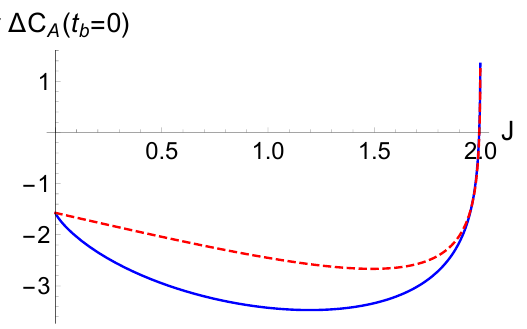
Figure 5 . π ∆ C A ( t b = 0) with M = 2 , ‘ = G N = α = L ct = 1 as a function of J . In blue solid with the counterterm, in red dashed without. In the extremal limit J → M‘ , the complexity of formation